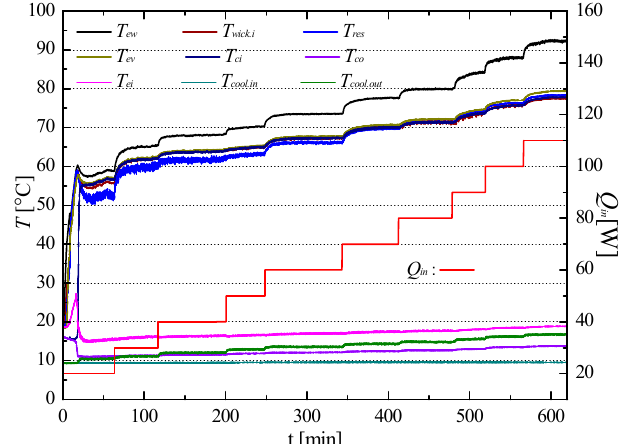
Figure 6. Trends concerning temperature change with step increase in evaporator thermal load when LHP setup was aligned horizontally.